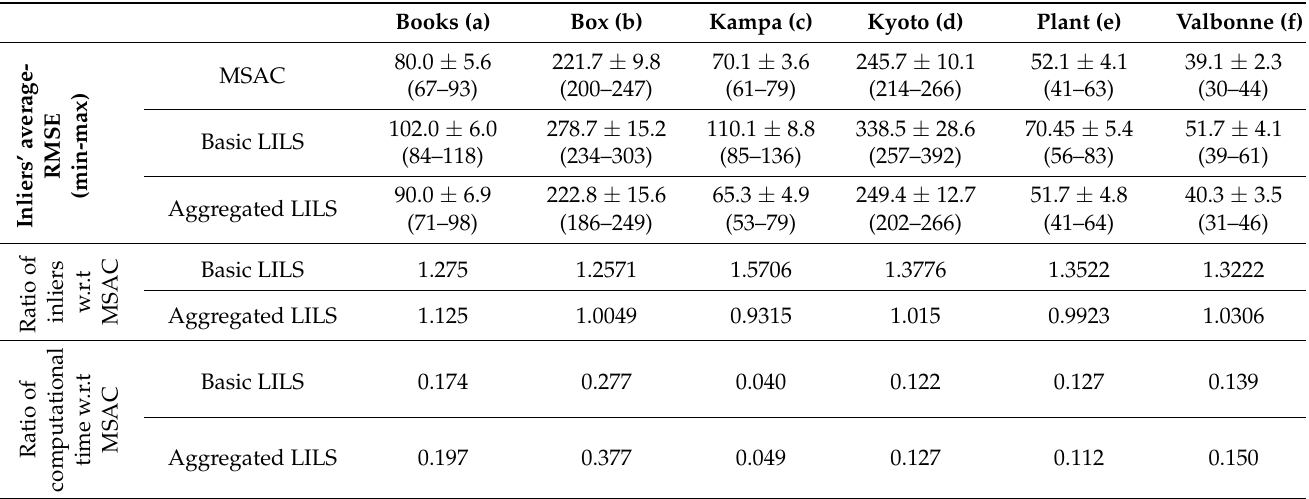
Table 4. The obtained results from all image pairs in the first